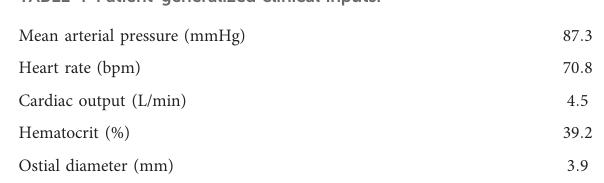
TABLE 4 Patient-generalized clinical inputs.